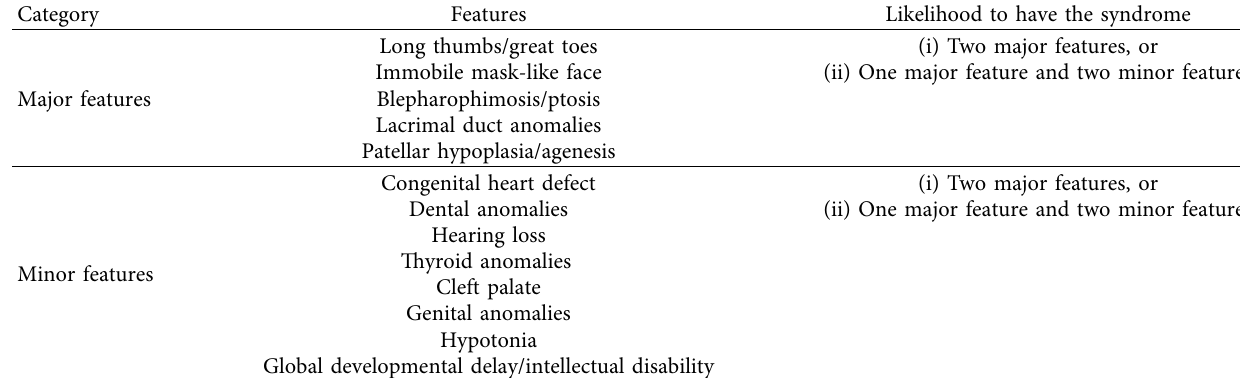
Figure 4: Patient 2: X-ray at follow-up. The patella is Table 2: Clinical diagnosis guide by Campeau et al. [3].